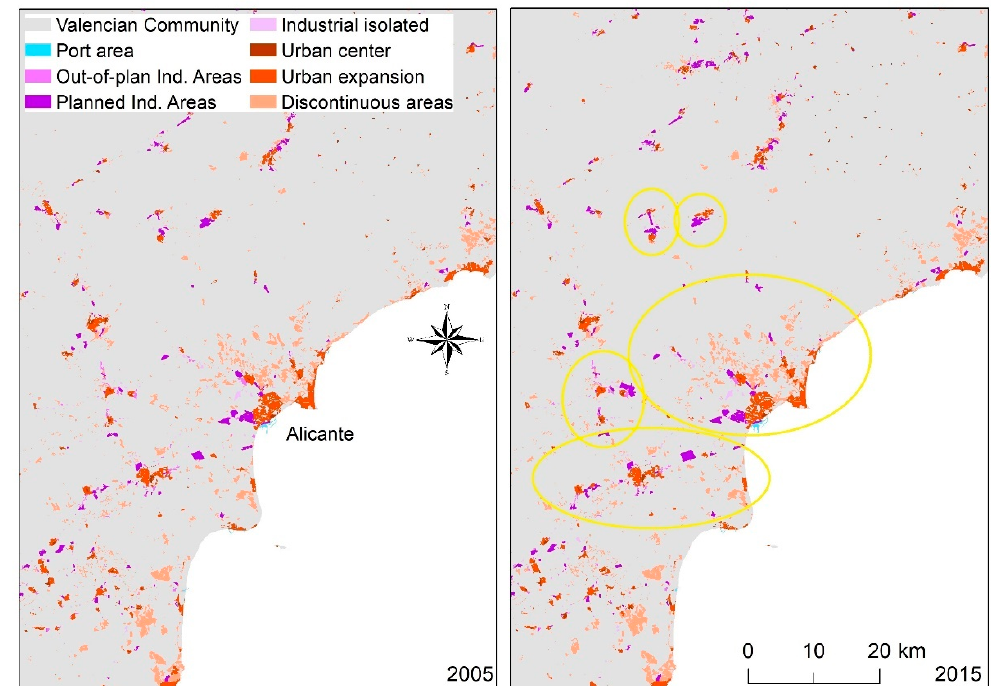
Figure 3. Spatial distribution of urban and industrial land-use in 2005 and 2015. From Castellón de la Plana (upper figures), Valencia (second row of figures) to Alicante (figures in bottom).